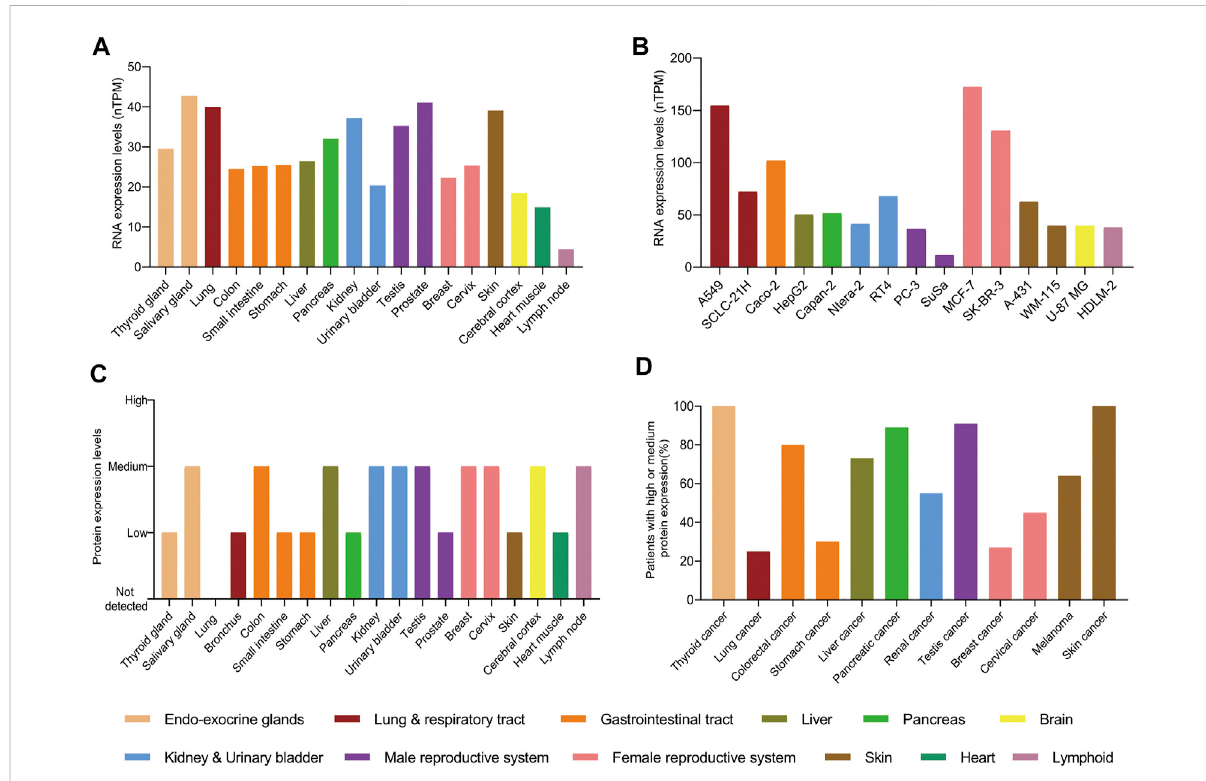
FIGURE 3 TheproteinandRNAlevelsofPAK4. (A) TheRNAlevelsofPAK4innormaltissues. (B) TheRNAlevelsofPAK4indifferentcancercelllines,nTPM: normalized transcript per million value. (C) The protein levels of PAK4 in normal tissues. (D) The percentage of patients with high or medium protein levels of PAK4 in various tumors. The tissues are distinguished in different colors. The data were integrated from